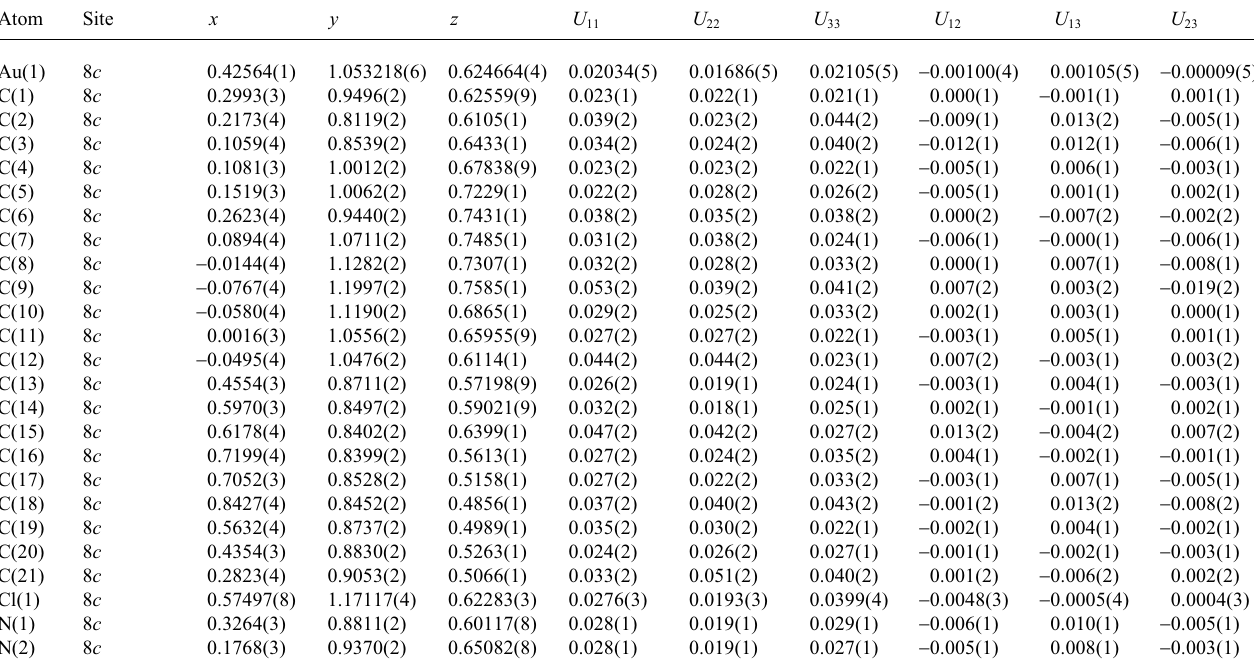
Table 3. Atomic coordinates and displacement parameters (in Å 2 )